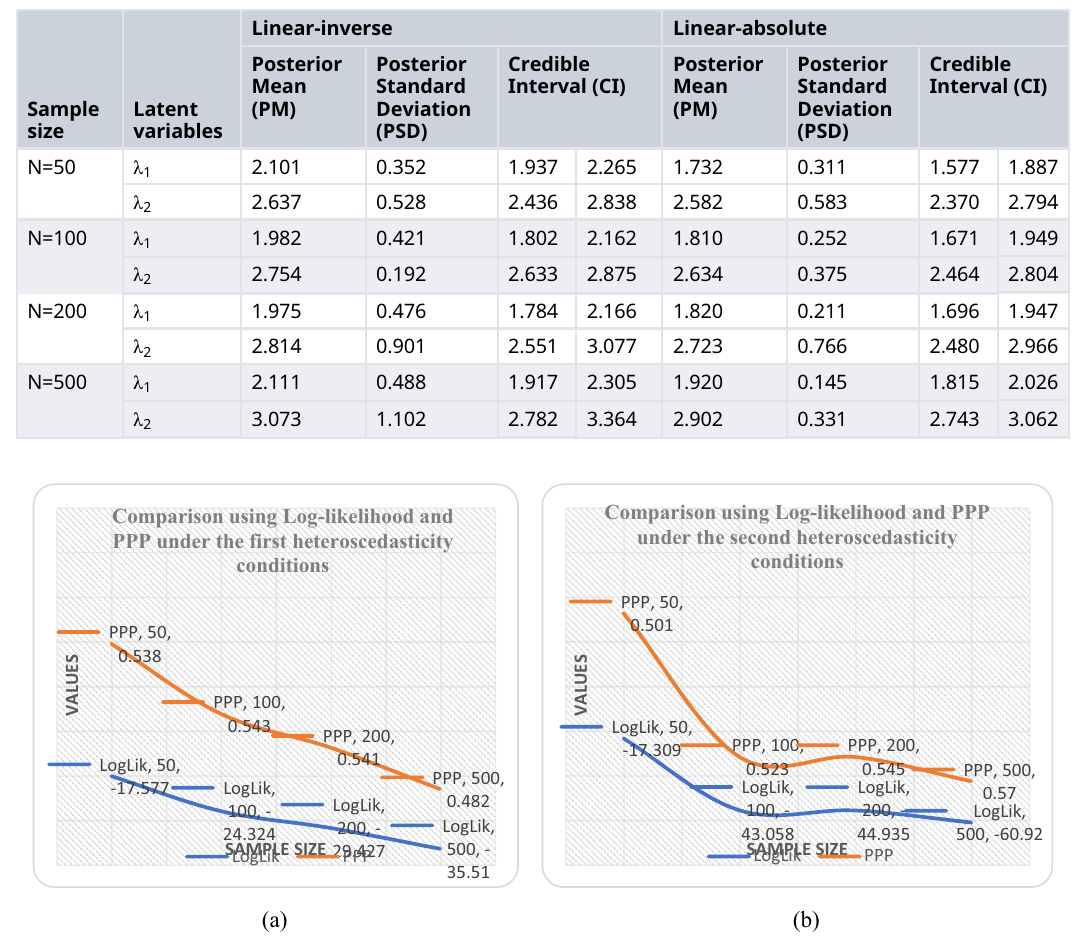
Figure 1. Plot of log likelihood and posterior predictive probability (PPP) at various sample sizes under (a) the double logarithmic form and (b) the linear form.